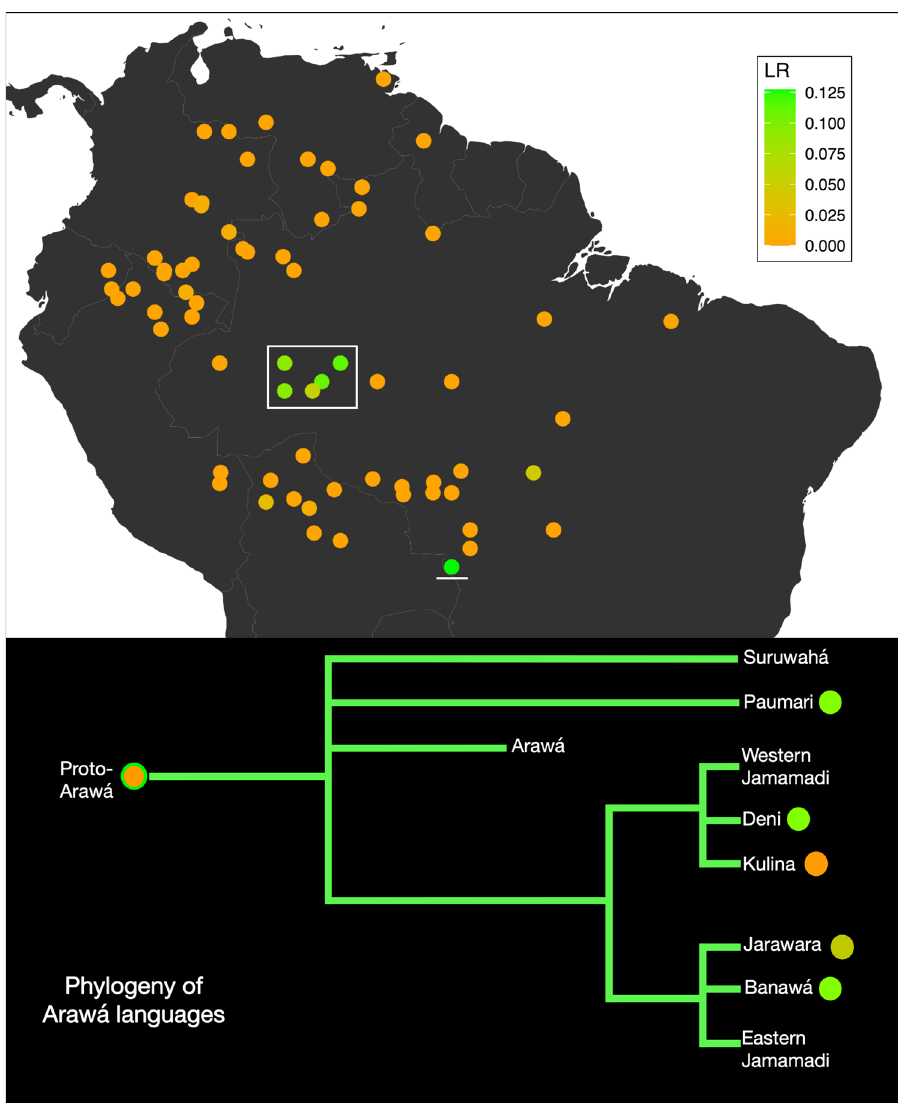
Figure 4. Top panel: map of Amazonian or Amazonia-adjacent doculects of HG groups. Arawá languages highlighted with box. The underlined circle denotes Guato. (See “possible exceptions” spreadsheet in SI.) Bottom panel: Family tree of Arawá languages, based on Dienst (2009), alongside their LRs where available 36 . The shading for proto-Arawá is based on the analysis in Dixon (2004) 33 . (Green border represents uncertainty).